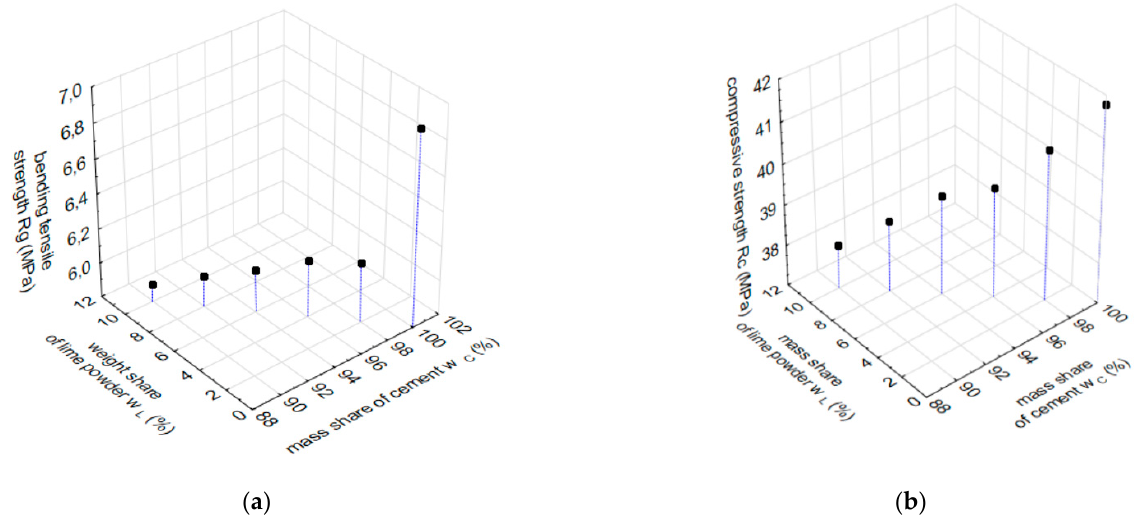
Figure 4. ( a ) Dependence of mean flexural tensile strength, Rg, and ( b ) compressive strength, Rc, on the simultaneous change of cement and limestone powder.